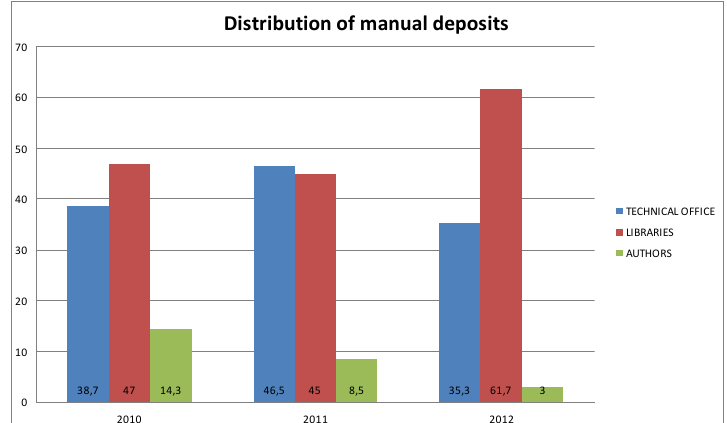
Figure 2. The graph shows how self-archiving and mediated archiving services have evolved in the last three years. The Mediated archiving is a service offered by DIGITAL.CSIC Technical Office and CSIC libraries network to researchers and overall more than 95% of manual uploads is carried out by CSIC library community.